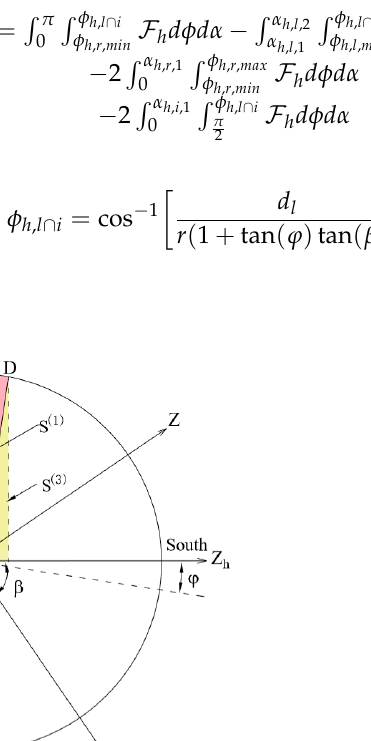
< 0 < d r and φ h while d l